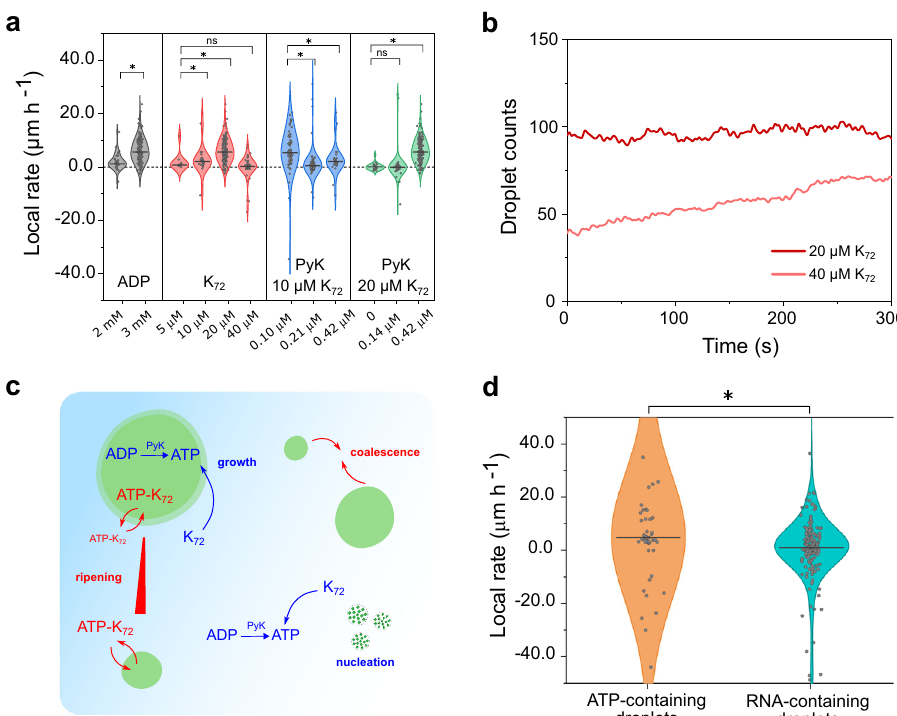
Fig. 6 Growth rate of active droplets. a Growth rate dependence on different reaction – diffusion conditions. The local rate was measured for all droplets in a frame within 200 s of the experiment. In different experiments, the concentration of ADP, K 72 , and PyK was varied. Median growth rate differences were evaluated as signi fi cant (*) or nonsigni fi cant (ns) in a Mood ’ s median test ( P < 0.05). Source data are provided in Supplementary Data 1. A complete overview of conditions and sample size can be found in Supplementary Table 1. b Droplet count during the growth phase of two of the experiments depicted in ( a ). c Active droplets undergo the processes in blue: they grow around seeding droplets or also nucleate in a supersaturated solution of K 72 . The passive processes in red — ripening and coalescence — are suppressed or minimized in our system. d Active droplets of different compositions grow at signi fi cantly different rates (*) in a Mood ’ s median test ( P < 0.05). Source data are provided in Supplementary Data